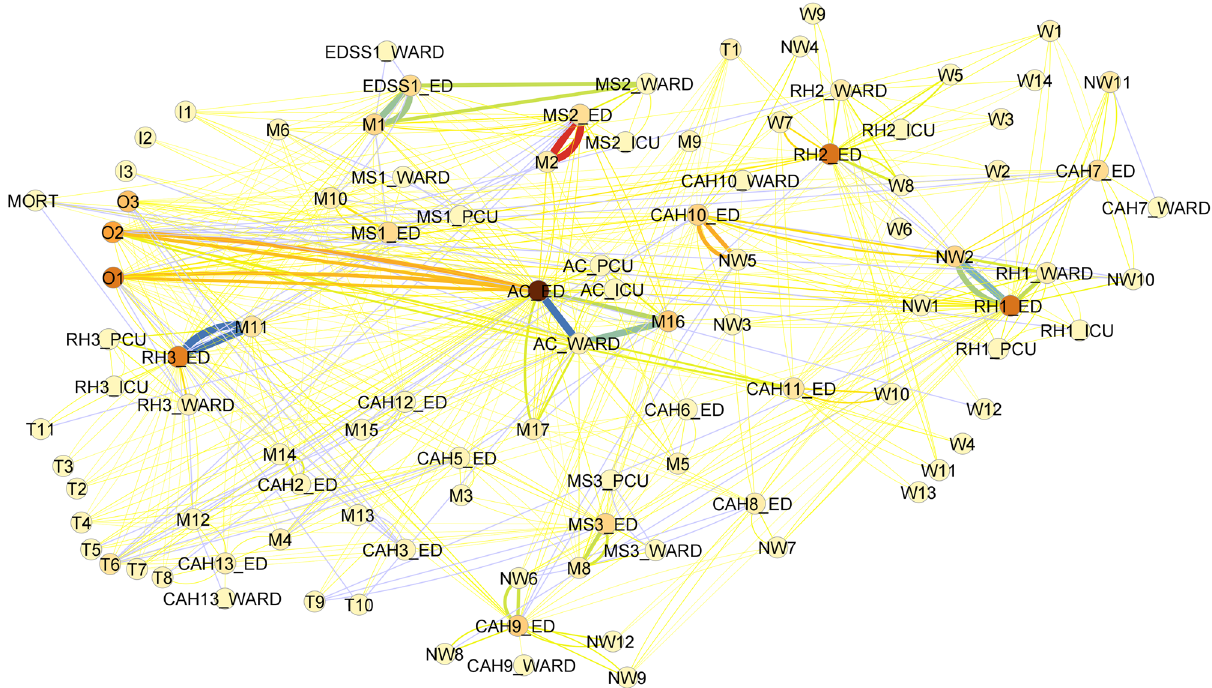
Figure 4. Difference network representing changes in patient movement between pre-and mid-pandemic. Node color represents degree connectivity (darker is higher) and increased edge weight/darker color represent a larger change between pre-and